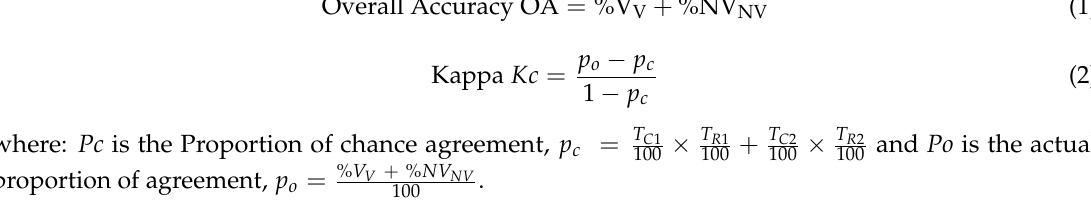
Table 4. Error matrix schema for validation of vineyard